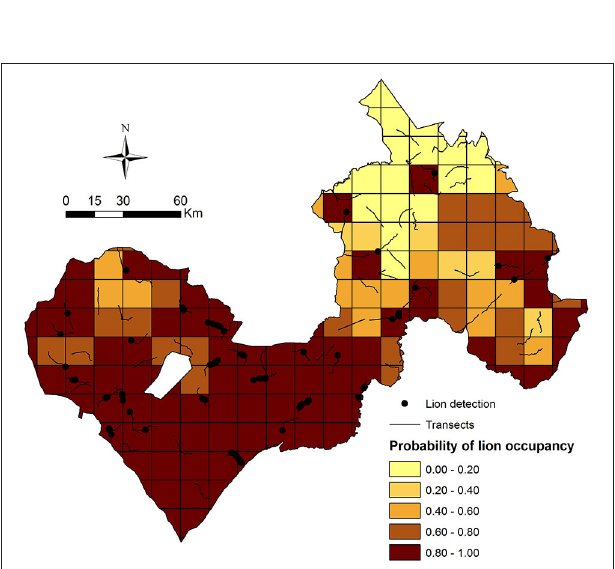
FIGURE 5 | Model-averaged occupancy ( ψ ) estimates in WAP sampling